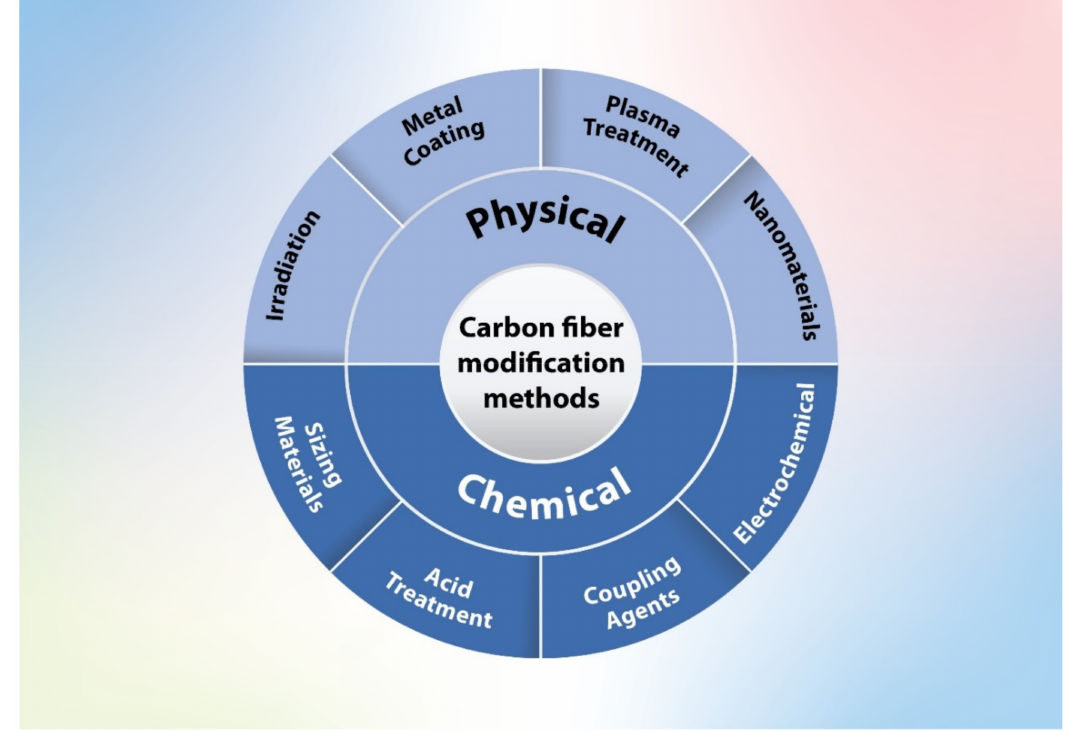
Figure 4. The standard treatment methods of CF